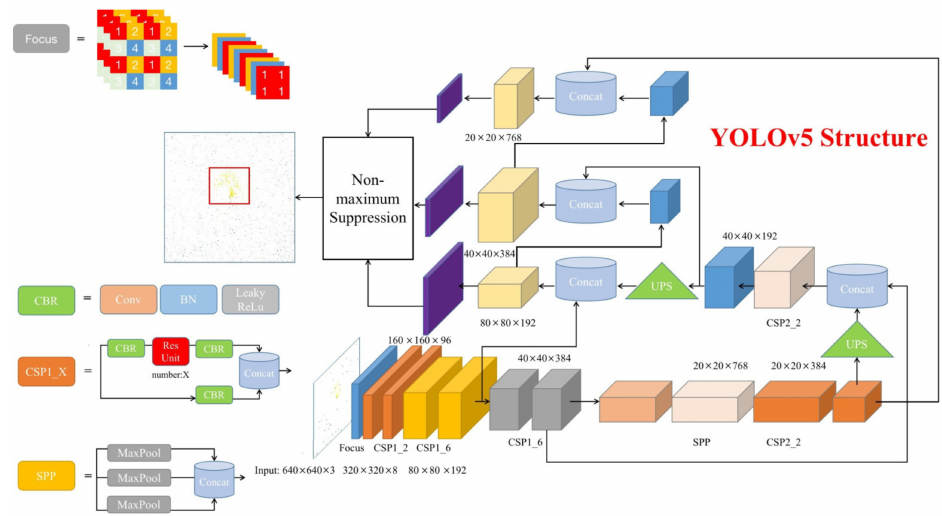
Figure 7. YOLOv5 model